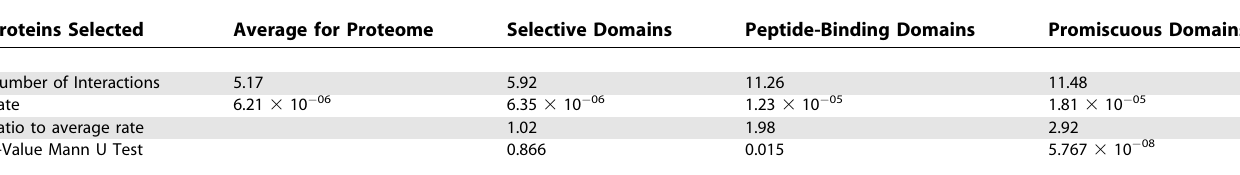
Table 3. Specificity of Protein Binding Is an Important Factor Determining the Rate of Change of Interactions Proteins Selected